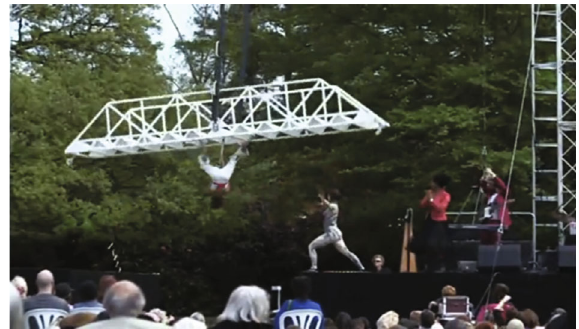
Figure 5: Disabled performers reclaiming the term “ freak show ”